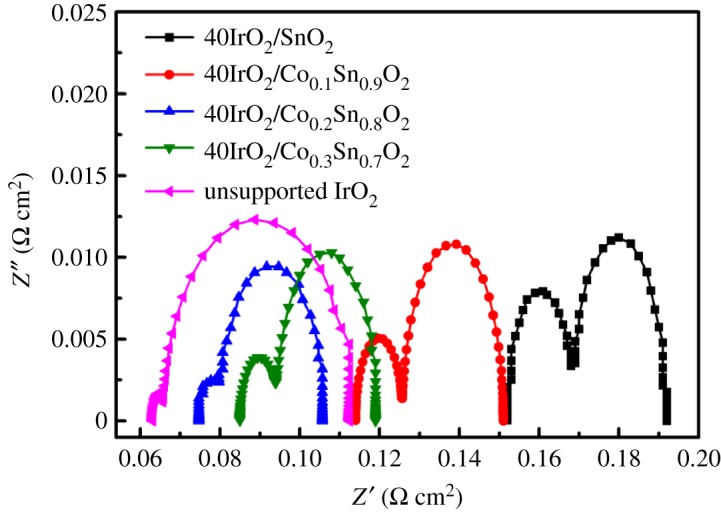
Nyquist diagrams of 40IrO2/CoxSn1−xO2 (x = 0, 0.1, 0.2, 0.3) and unsupported IrO2 at 0.3 A cm−2 and 80°C.